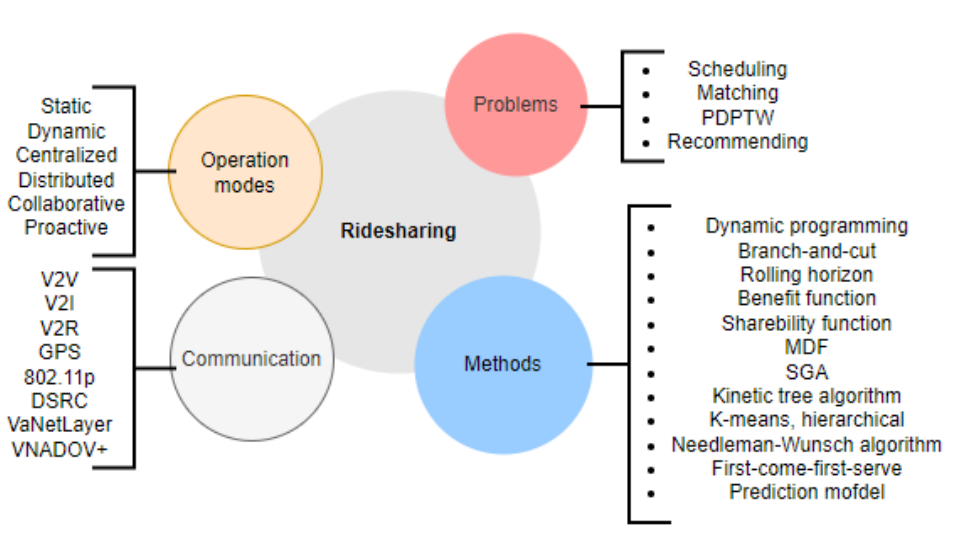
Figure 4. Operation of